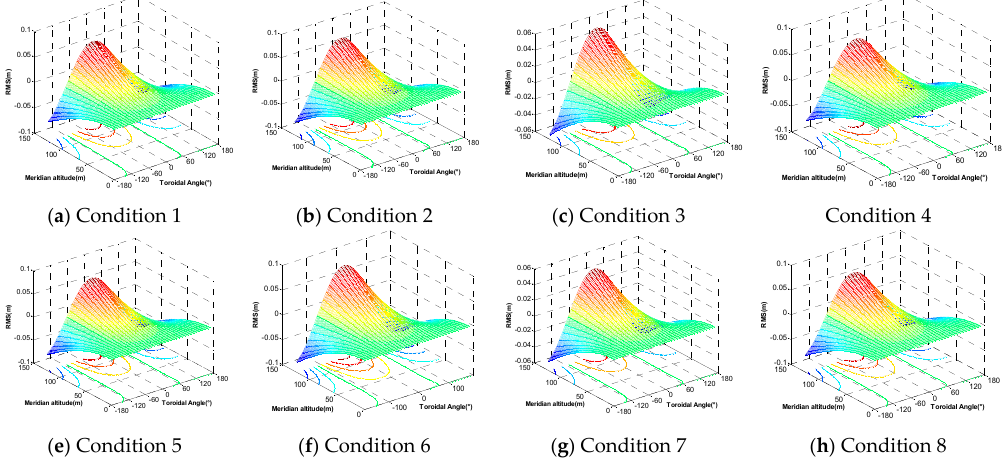
Figure 23. Distributions of RMS of mean radial displacement of the tower body under different conditions.